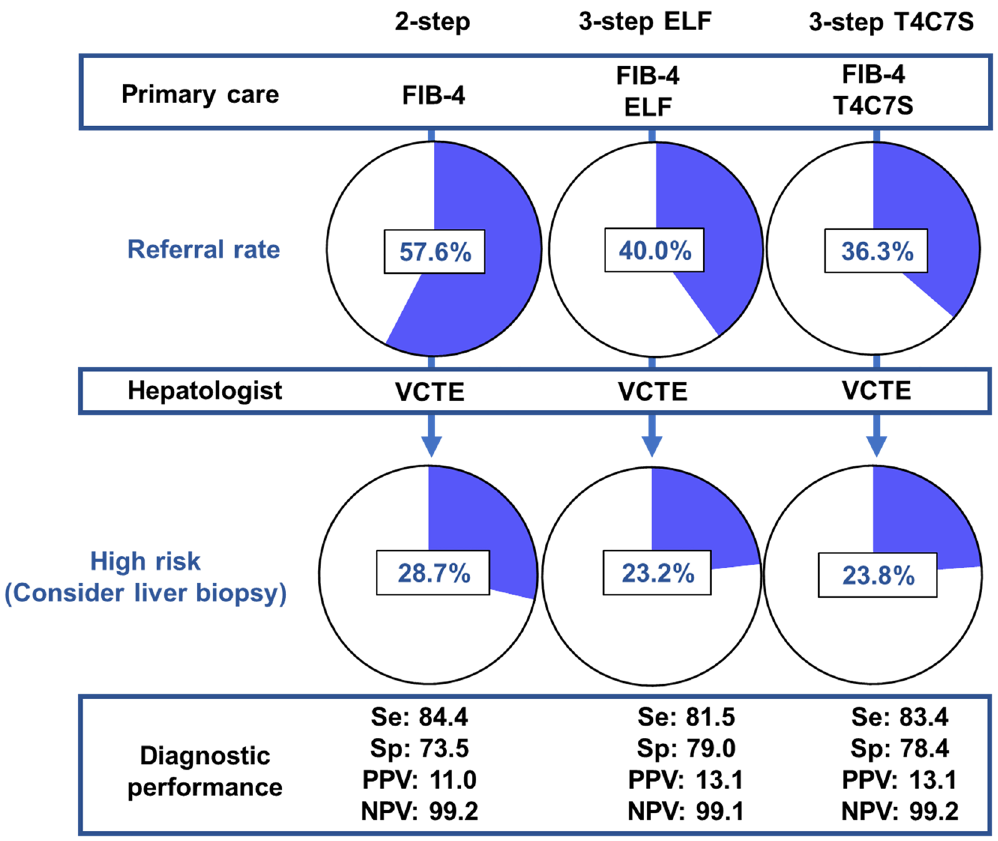
Figure 2. Comparison of each approach applied to a cohort with a low prevalence of advanced fibrosis (3.7%); the 3-step approach can reduce patient referral and liver biopsy rates without losing diagnostic performance. The numbers listed are means. ELF, enhanced liver fibrosis test; FIB-4, Fibrosis-4 index; T4C7S, type IV collagen 7S domain; VCTE, vibration-controlled transient elastography; Se, sensitivity; Sp, specificity; PPV, positive predictive value; NPV, negative predictive